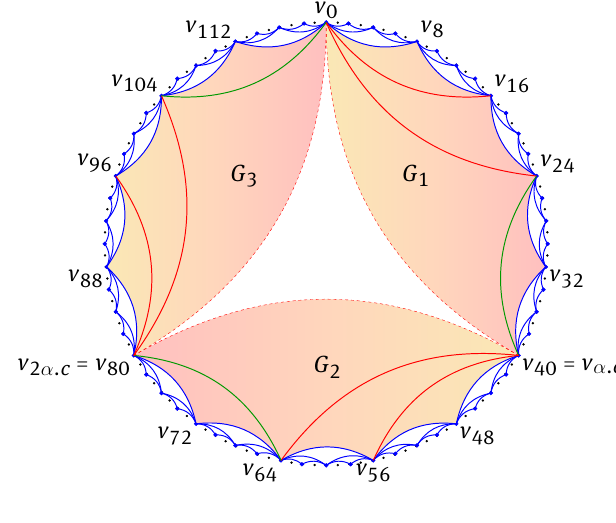
Fig. 6. n = 120 , t = 15 , r = 3 , and α = 5